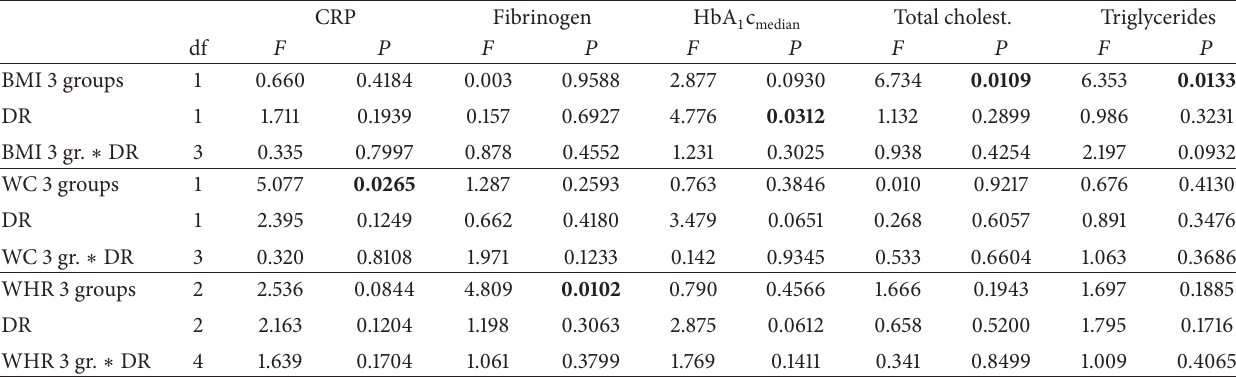
Table 3: Differences in C-reactive protein, fibrinogen, HbA three groups according to the diabetic retinopathy status and the level of obesity defined by BMI, WC, and WHR.